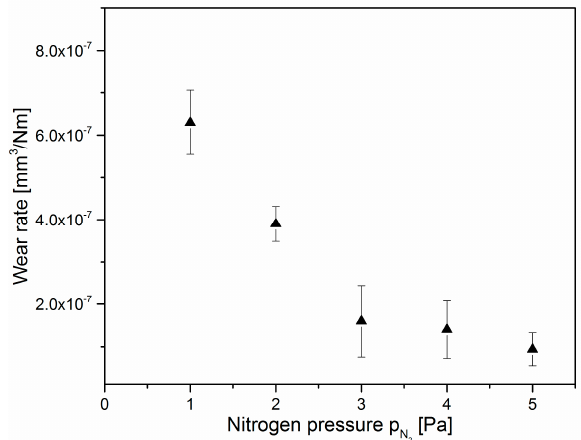
Figure 13. Wear rate of the coatings deposited using substrate temperature of 350 °C, substrate bias voltage U B = − 100 V and different nitrogen pressure.